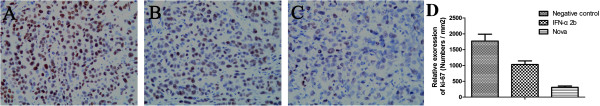
Ki-67protein levels ingroup of IFN-α2b (B) and Nova (C) compared with the negative control (A) by immuno histochemical analysis. D is quantization of the expression of the proteins evaluated in the different samples with immunohistochemistry.